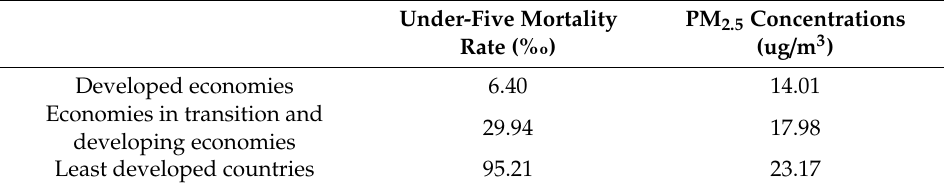
Table 5. Mean of under-five mortality and PM 2.5 concentrations in di ff erent types of